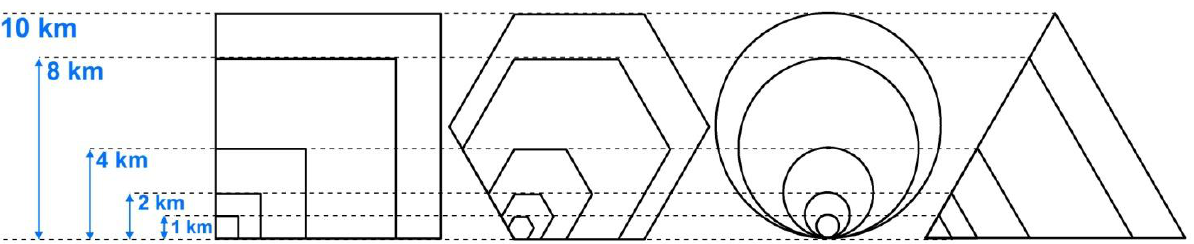
Fig. 3. Sizes and shapes of used basic fields